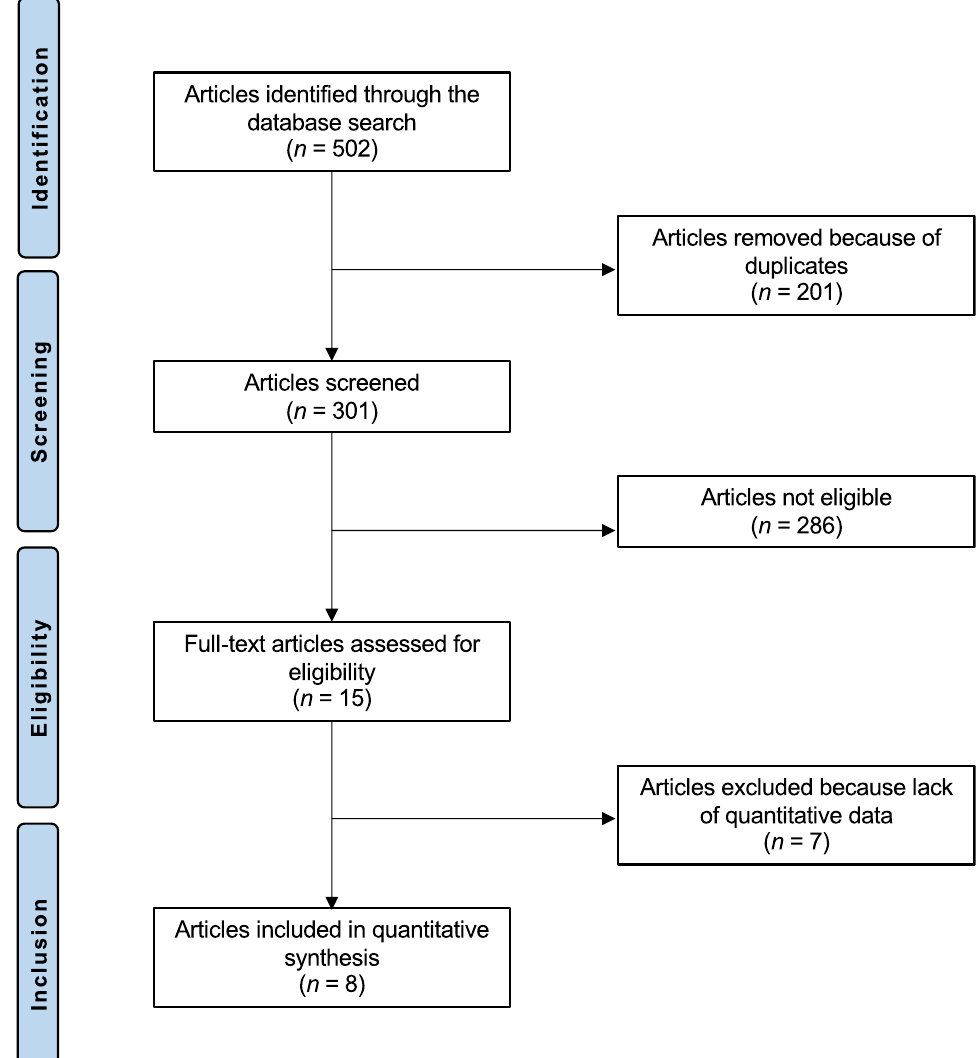
Fig. 1 Flow chart of the literature search